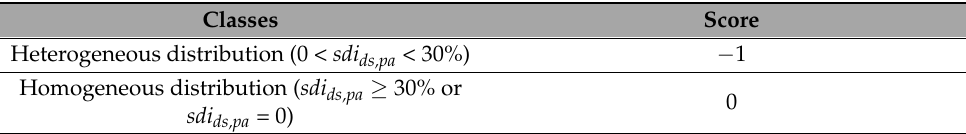
Table 9. SDi ds,pa —spatial distribution. Classes Heterogeneous distribution (0 < sdi ds,pa < 30%)